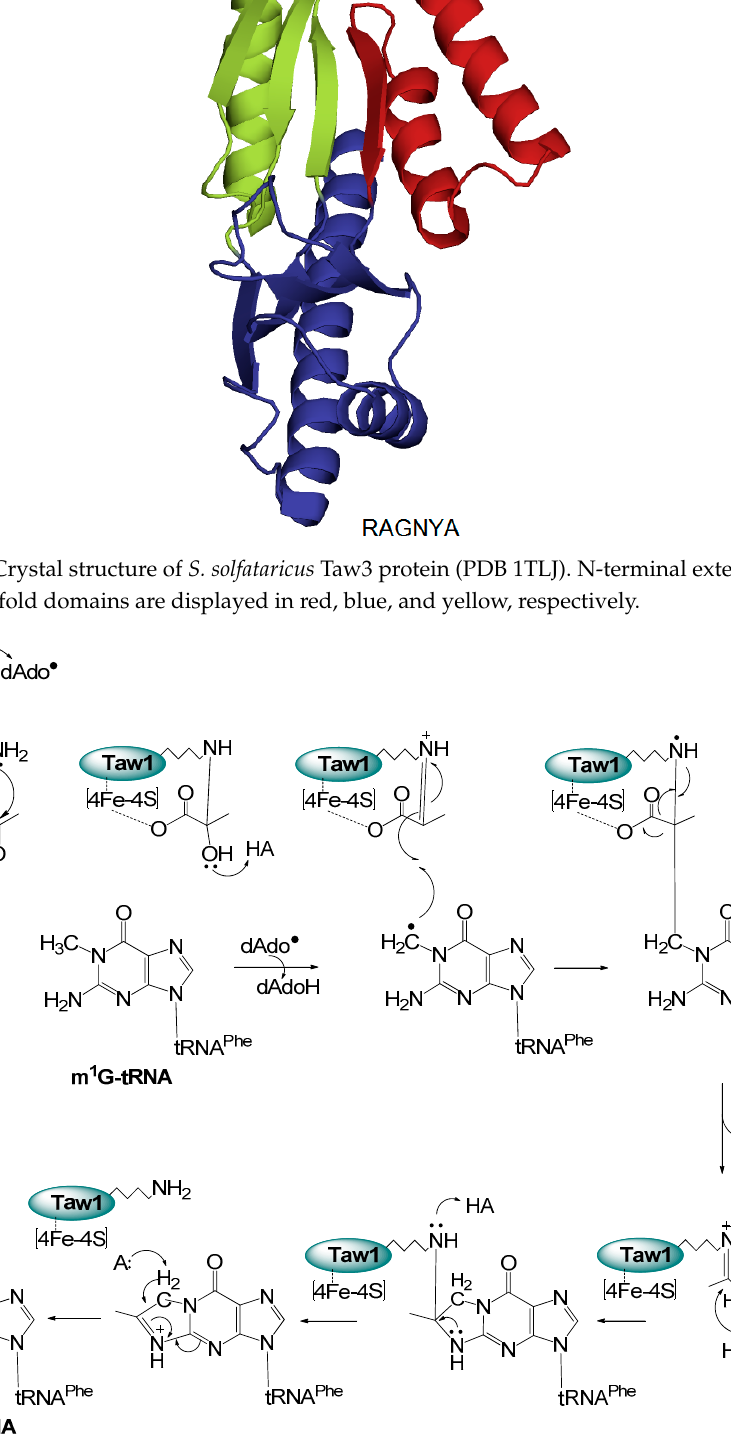
Scheme 2. The proposed enzymatic mechanism for Taw1.